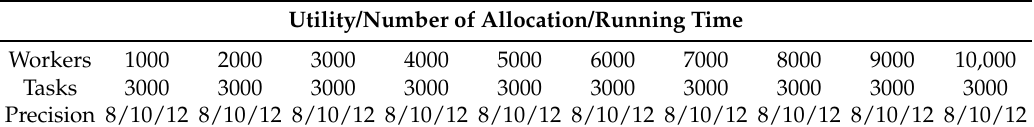
Table 3. Experimental settings for the effect of precision.